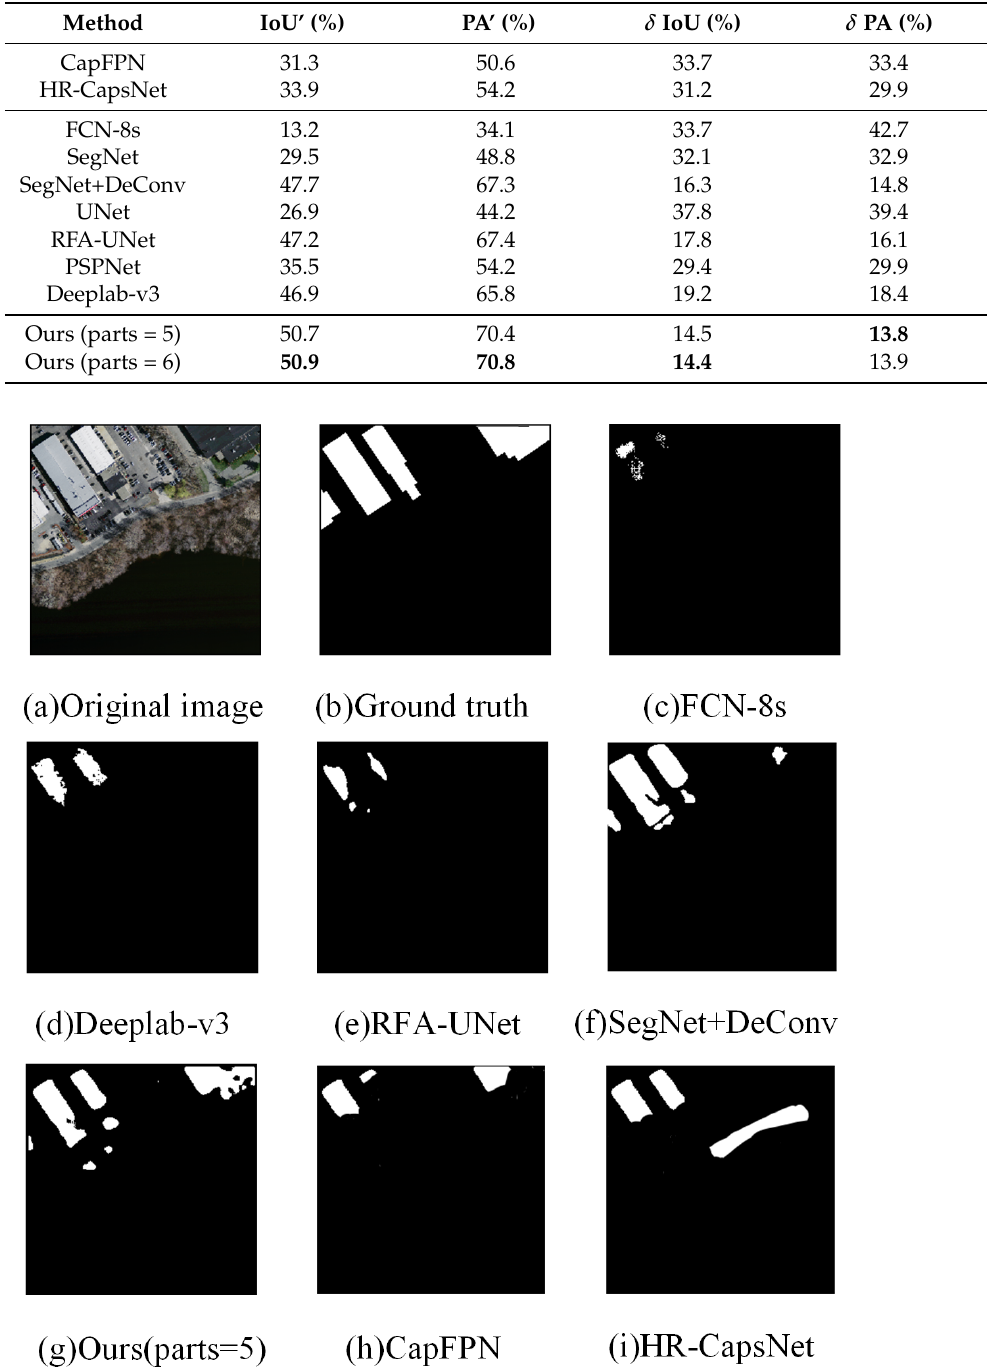
Figure 8. Comparison of the building extraction of different methods on unfamiliar data. For Deeplab-v3, multiscale atrous convolution helps the model to obtain more context information. Therefore, Deeplab-v3 can better perceive the target object. The attention mech- anism helps RFA-UNet capture the distributions of target objects in remote sensing images, but the performance is not as good as Deeplab-v3. In addition, SegNet+DeformableConv uses deformable convolution, which can adapt to the spatial transformation of target ob- jects’ parts. Therefore, SegNet+DeformableConv performs better than other